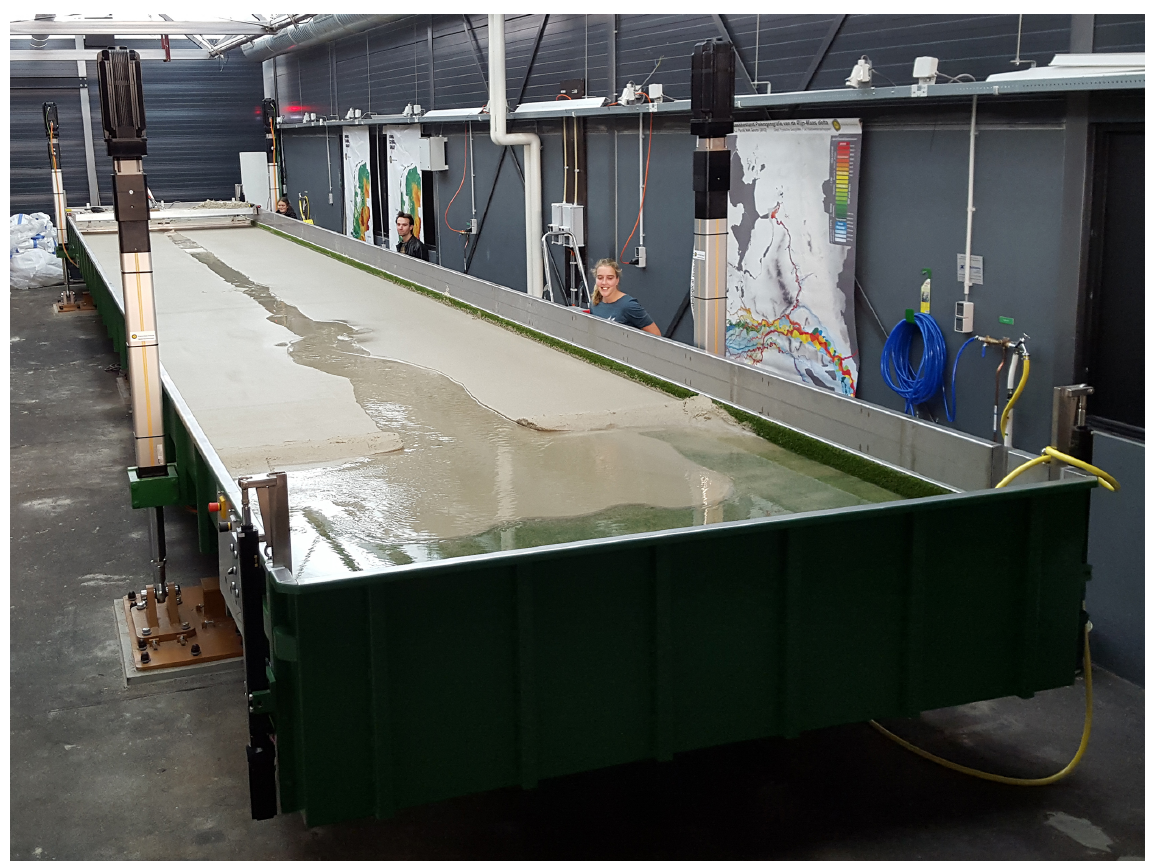
Figure 2. The Metronome tidal facility. Note PhD candidates for scale. The flume floor below the sand is covered in artificial grass (see text). Note the vertically mounted actuators that drive the flow. This pilot experiment started as a 0.2m × 0.03m straight initial channel and ran for about 12h with a slope amplitude of 0.005mm − 1 and a period of 30s and 100Lh − 1 river inflow.